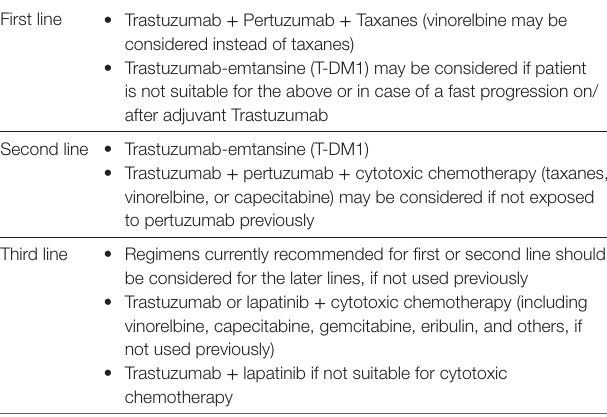
TABLe 1 | Current consensus sequencing of metastatic treatment in human epidermal growth factor receptor 2 (HER2)-positive metastatic breast cancer